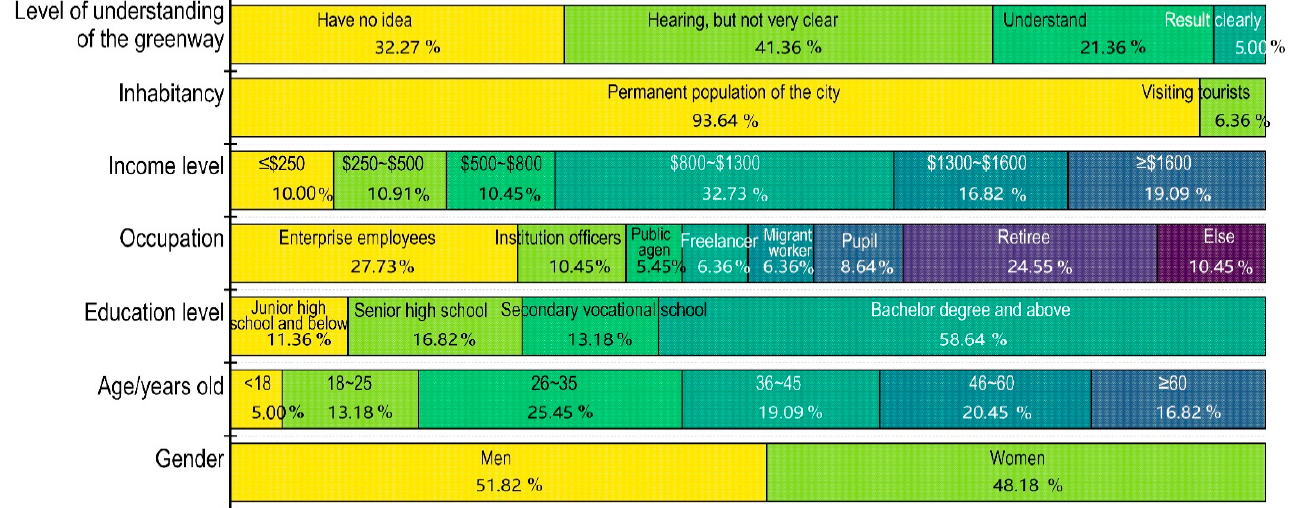
Figure 3. Demographic characteristics of the sample. Table 3. Chi-square test of pairwise comparison of socioeconomic